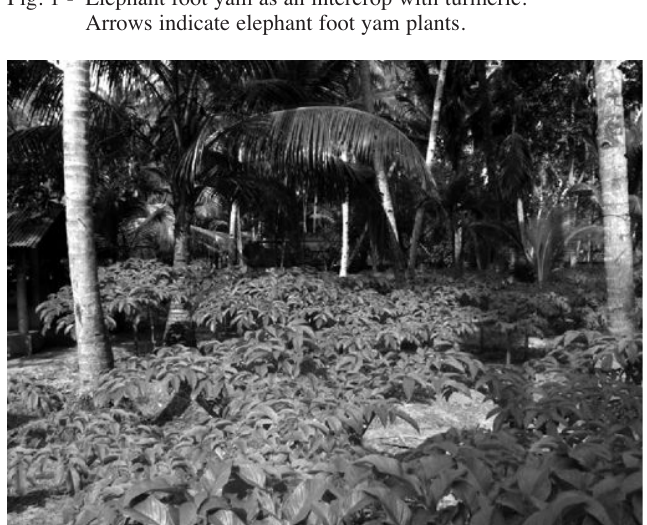
Fig. 2 - Elephant foot yam under